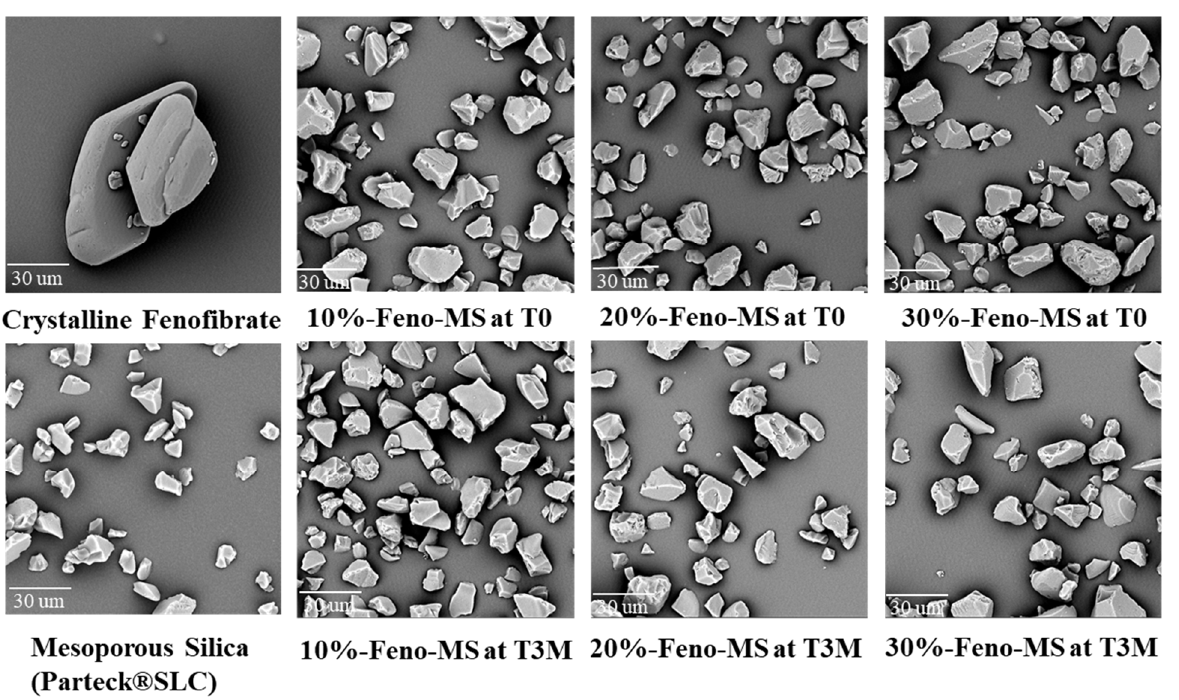
Figure 2 . SEM images of Feno-MS samples (10%, 20%, and 30% drug load at T0 and T3M under accelerated conditions of 40 °C/75% RH in open dish), crystalline fenofibrate, and mesoporous silica (Parteck ® SLC).